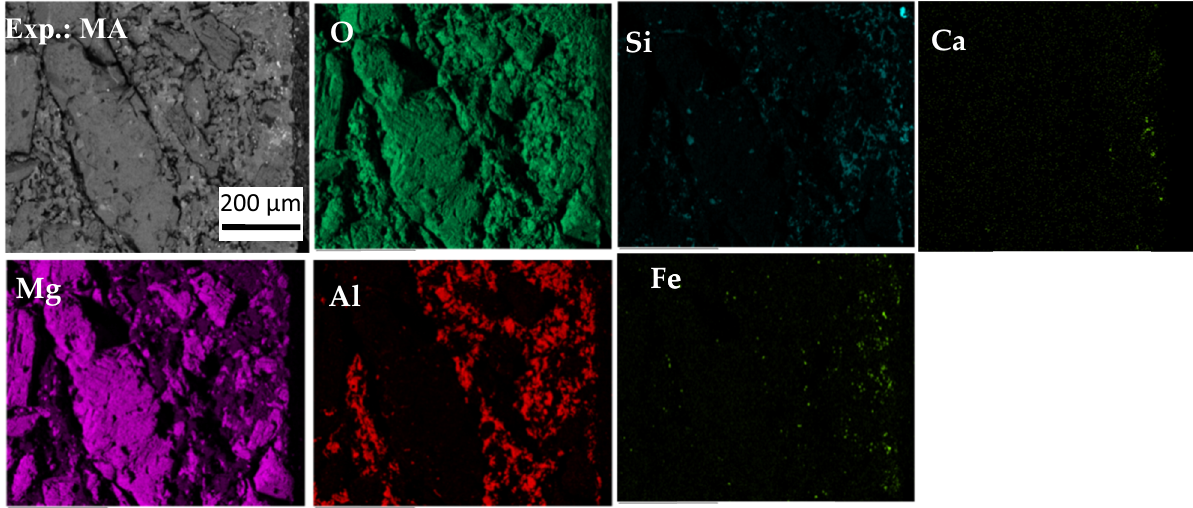
Figure 9: Element mapping results of MgO · Al 2 O 3 crucible.